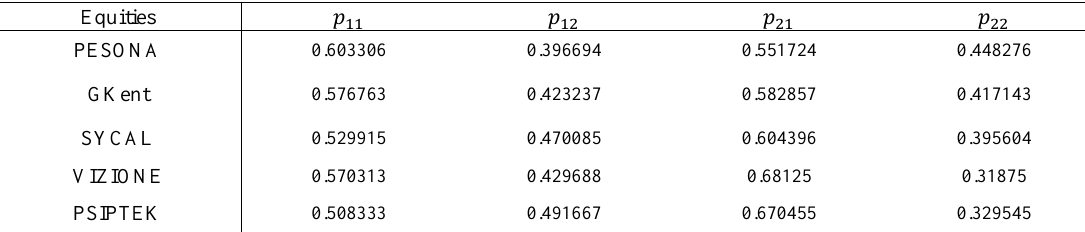
Table 4. Entries of two-state transition matrices for selected